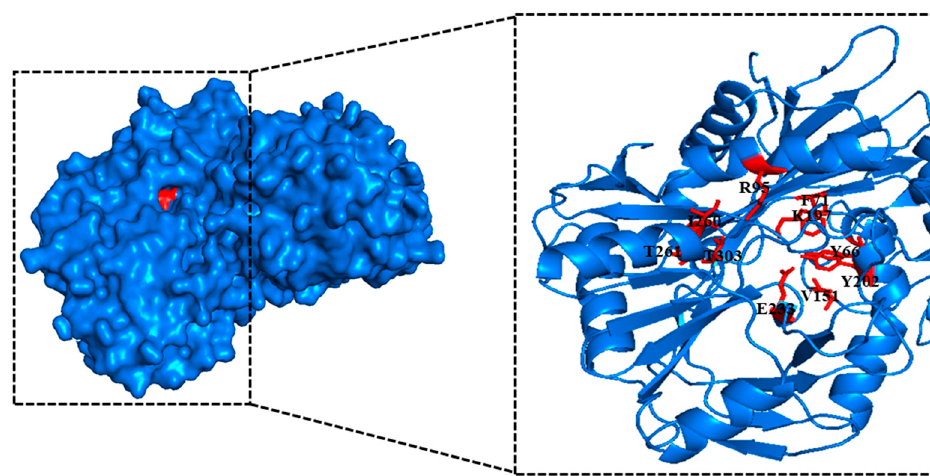
Figure 2. Homology modelling structure of BpAT-2 showing conserved domains. The 10 residues in red (Y66, F71, R95, V151, K197, Y202, E233, I260, T261 and T303) constitute the catalytic site and the cofactor-binding pocket of BpAT-2.